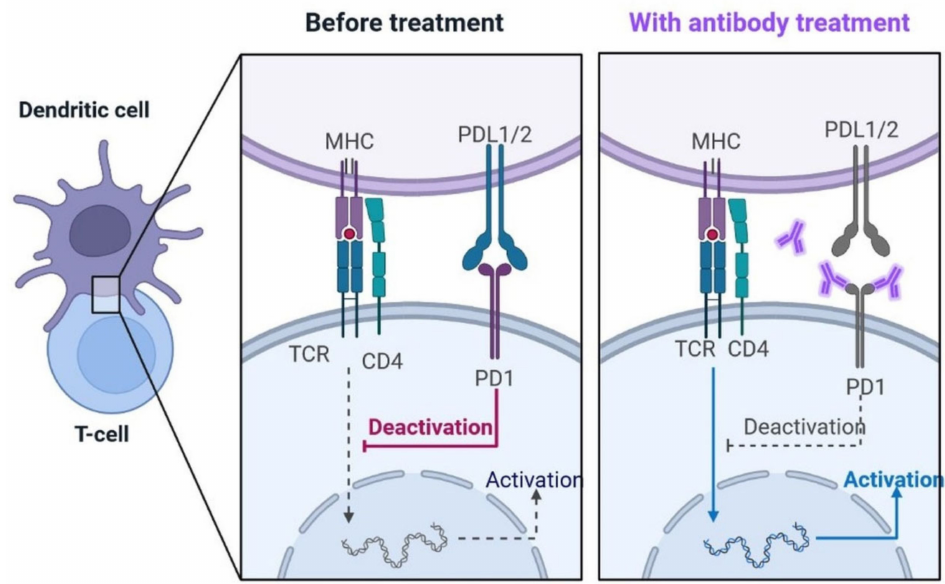
Figure 20. PD-1 Blocking Antibodies: Monoclonal antibodies blocking the activity of PD-1 can increase T cell proliferation, cytokine production, and reduce death in patients with severe pneumonia associated with